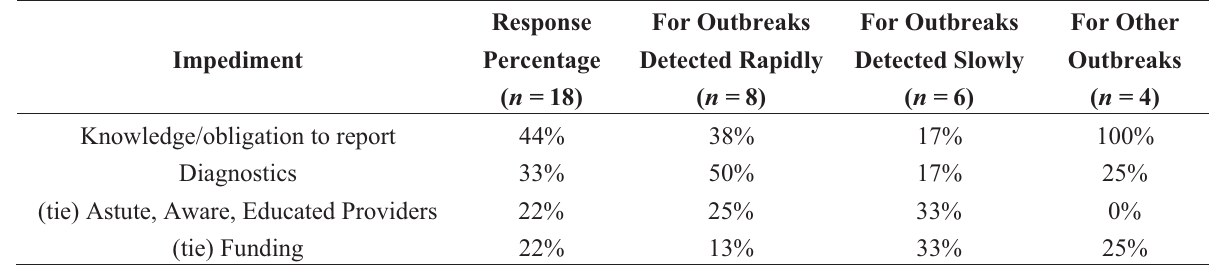
Table 3. Top Three Impediments for Zoonotic Disease Outbreak Detection and Reporting.